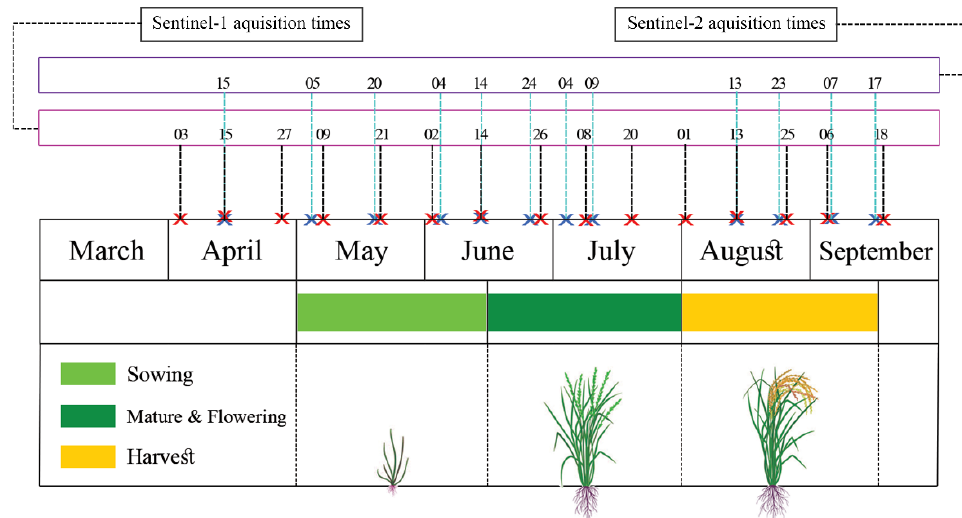
Figure 2. Sentinel-1 and Sentinel-2 acquisition dates (2019) and phenology stages of rice crop in the Mazandaran province, Iran.